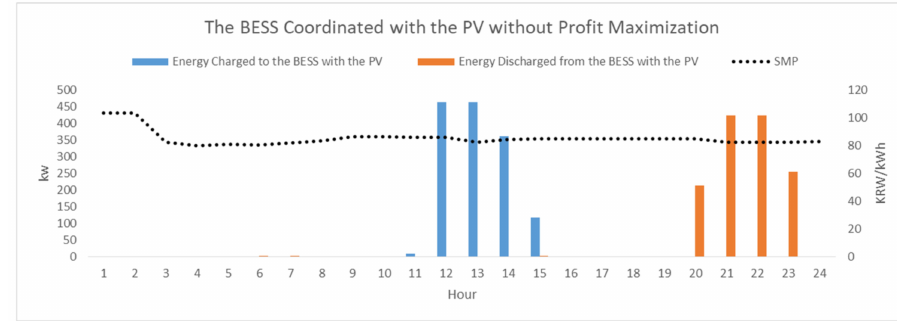
Figure 6. Intraday operation of the BESS charging and discharging.